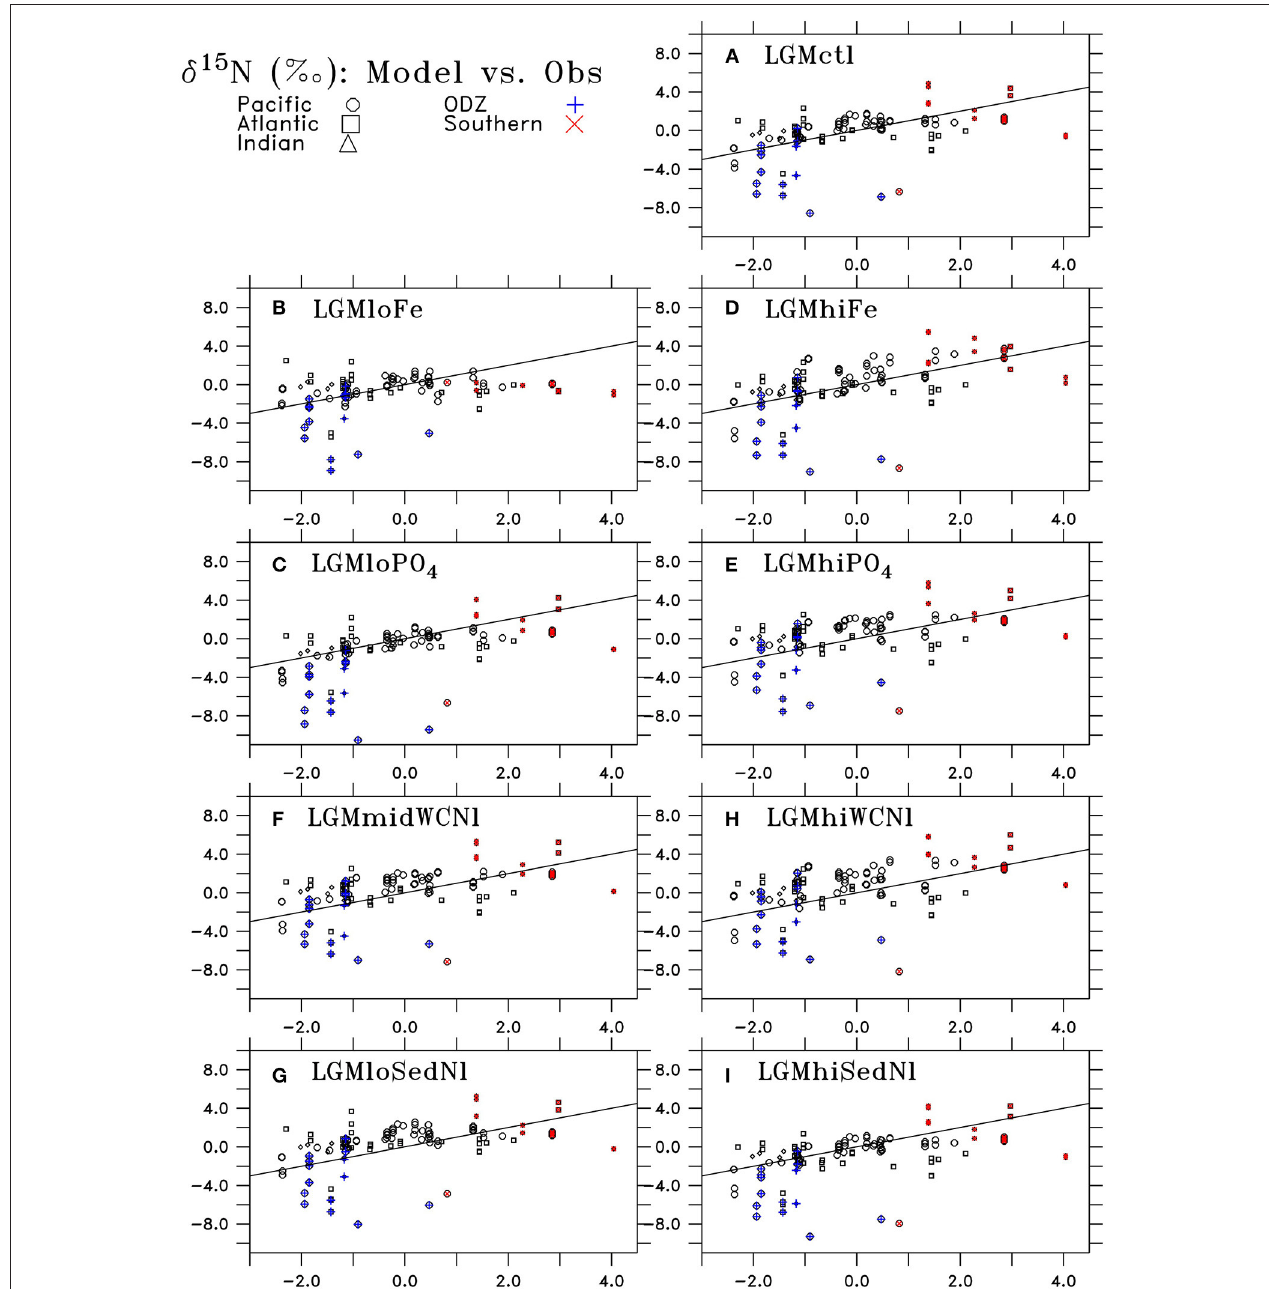
FIGURE 10 | Comparison of LGM minus PI changes in sedimentary δ 15 N from observations (horizontal axis) and model results (vertical axis) of (A) LGMctl, (B) LGMloFe, (C) LGMloPO 3 − 4 , (D) LGMhiFe, (E) LGMhiPO 3 − 4 , (F) LGMmidWCNl, (G) LGMloSedNl, (H) LGMhiWCNl, and (I) LGMhiSedNl. Locations in the Pacific, Atlantic, and Indian Oceans are shown as circles, squares, and triangles, respectively. Locations in oxygen deficient zones (ODZ; minimum O 2 < 10mmolm − 3 ) are shown as blue crosses and Southern Ocean (south of 40 ◦ S) are red Xs. The black line indicates a “perfect” representation of